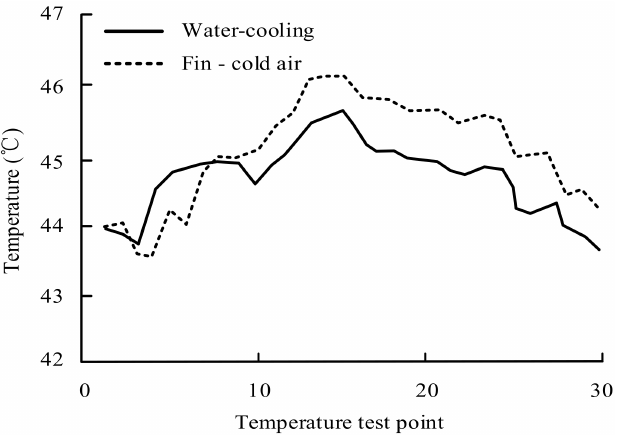
Figure 7. Comparison of the cooling effect under finned air-cooling and water-cooling